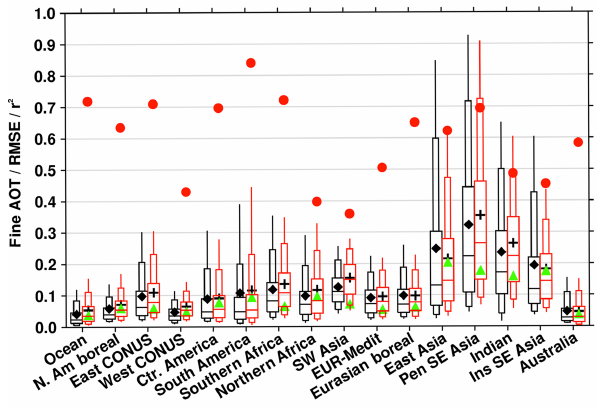
Figure 10. Comparison of regional fine-mode AOT at 550nm of the reanalysis (red) at 95, 90, 75, 50, 25, 10 and 5% percentiles to the pairwise AERONET L2 data (black) for the regions defined in Fig. 4 for the 10-year time period (June 2003–May 2013). Also shown are the regional mean of the reanalysis and AERONET fine- mode AOTs in “ + ” and diamond, respectively. Green triangles rep- resent the root mean square error (RMSE) of the reanalysis. Red dots represent the square of the Pearson correlation coefficient ( r 2 ) between the reanalysis and the AERONET observations.